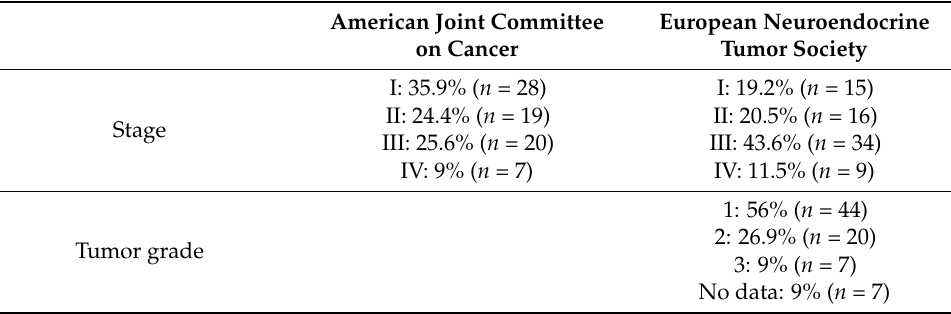
Table 2. Tumor stage and grade